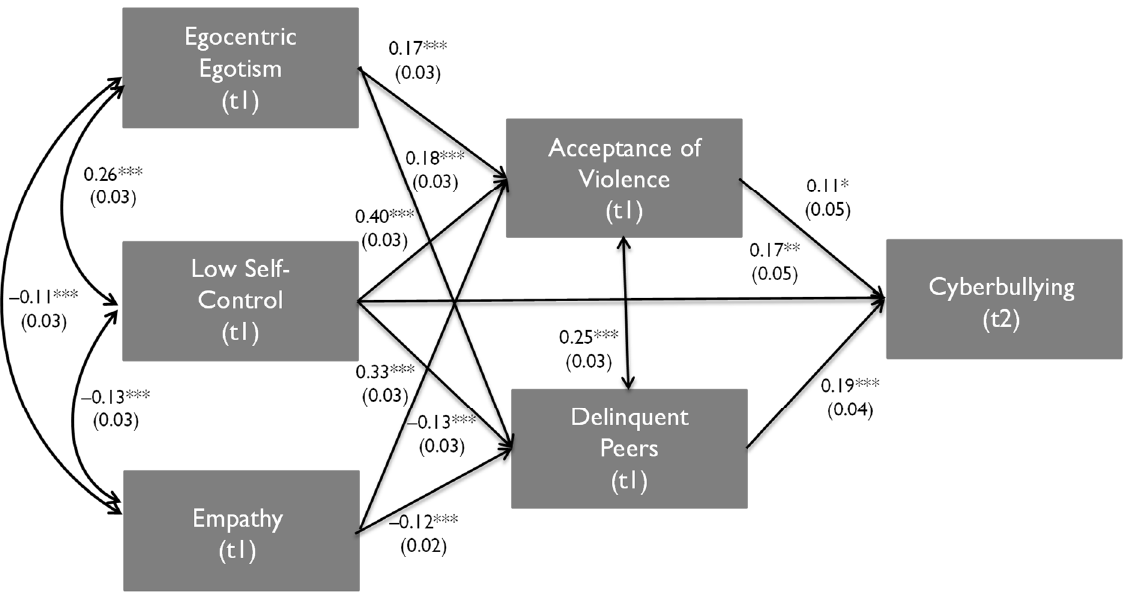
Figure 2. Developmental path model for the youth cohort (t1–t2, two-wave panel). * p < 0.05, ** p < 0.01, *** p < 0.001.